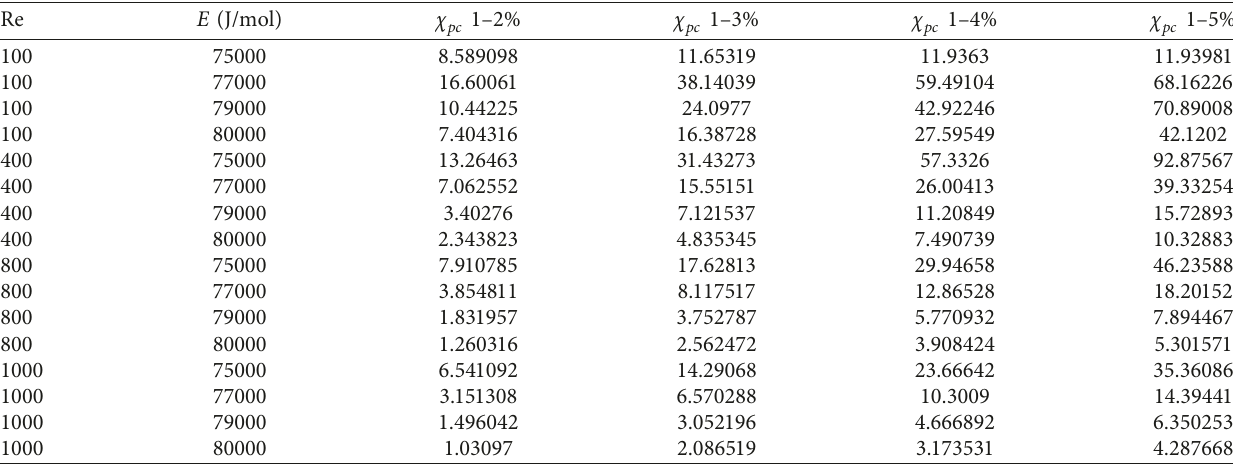
Figure 7: Conversion profile of CaO against the length of the reactor: (a) I.C � 5%, E � 80,000J/mol; (b) I.C � 5%, Re � 1000; (c) Re � 1000, E � 80,000J/mol. Table 2: Percentage improved conversion profile from 1% of initial concentration to